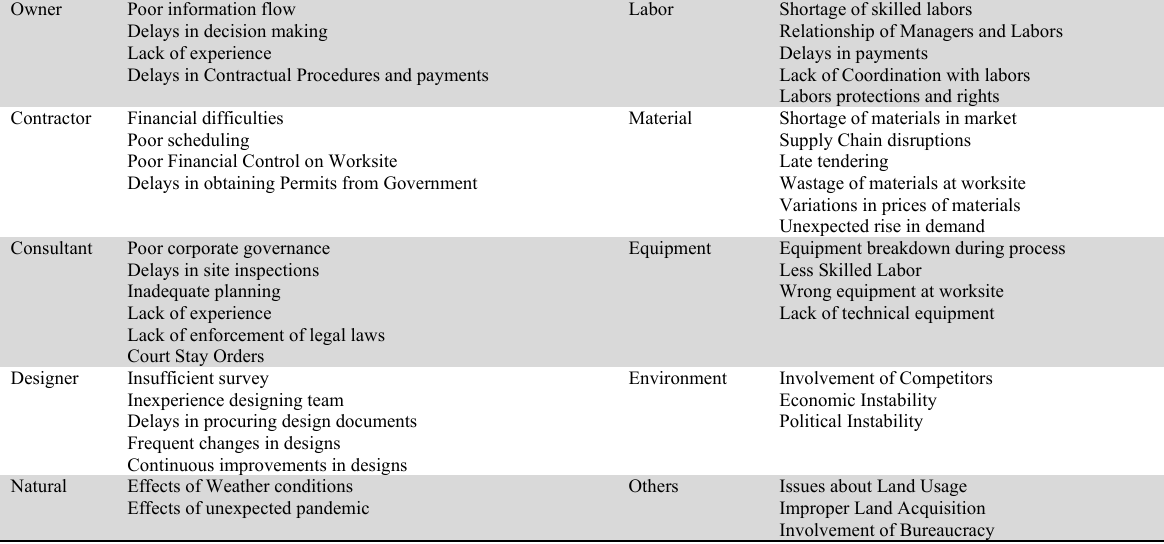
Stakeholder’s Perspective of Infrastructure Projects Failures